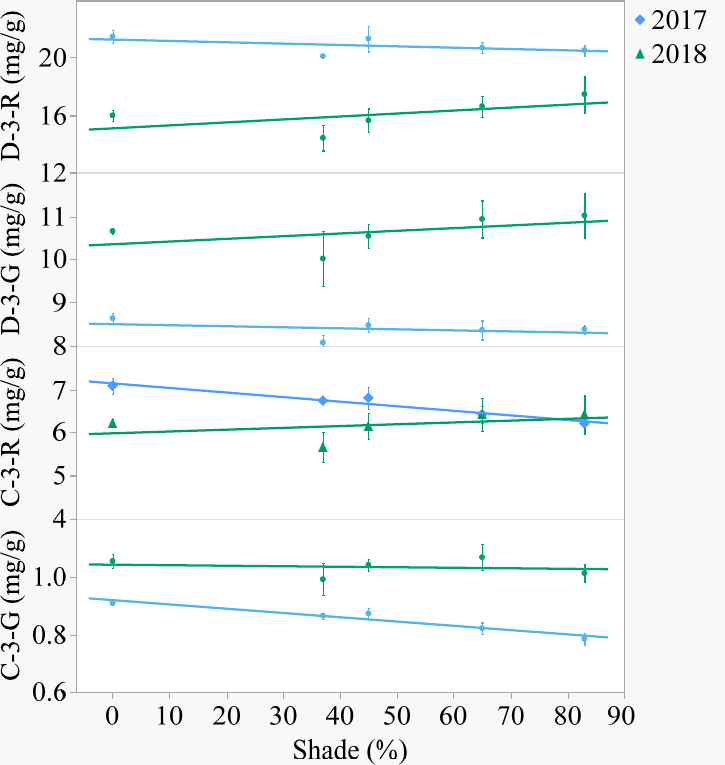
Figure 3. Artificial shade treatment effects on the four major anthocyanins of lyophilized black currant berries ( Ribes nigrum c.v ‘Consort’) grown in Urbana, IL in 2017 and 2018. Anthocyanins measured were delphinidin-3- O -rutinoside (D-3-R), delphinidin-3- O -glucoside (D-3-G), cyanidin-3- O -rutinoside (C-3-R), and cyanidin-3- O -glucoside (C-3-G). Data are presented as the mean mg/g dry weight ± standard error of n-4 replicates. Regression equations (where x = percent shade) were as follows: D-3-R (2017) = 21.27 − 0.0095x, r 2 = 0.07, p value = 0.2688; D-3-R (2018) = 15.07 − 0.0207x, r 2 = 0.10, p value = 0.1720; D-3-G (2017) = 8.50 − 0.0024x, r 2 = 0.04, p value = 0.4015; D-3-G (2018) = 10.35 − 0.0062x, r 2 = 0.04, p value = 0.3743; C-3-R (2017) = 7.15 − 0.0106x, r 2 = 0.49, p value = 0.0005; C-3-R (2018) = 5.99 + 0.0042x, r 2 = 0.03, p value = 0.4451; C-3-G (2017) = 0.92 − 0.0015x, r 2 = 0.66, p value < 0.0001; C-3-G (2018) = 1.04 − 0.0002x, r 2 = 0.01, p value = 0.7626.